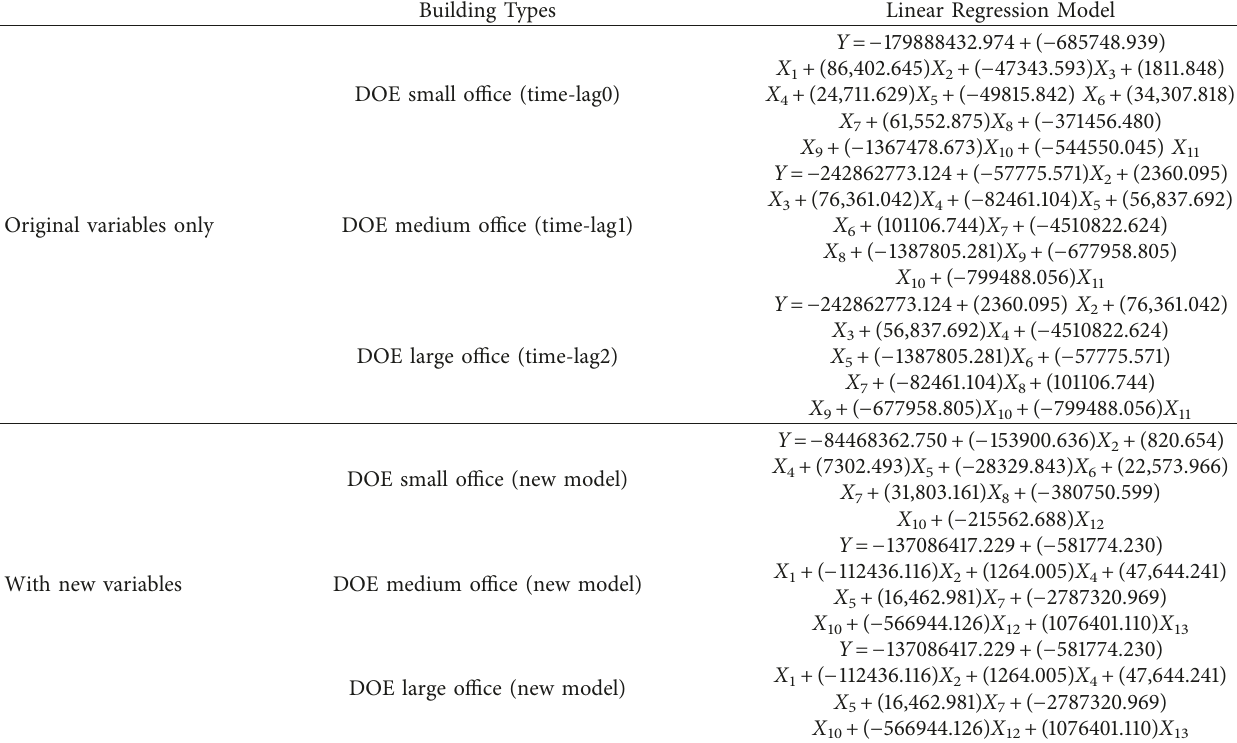
Table 26: Multiple regression equations using new variables based on building size. Building Types Linear Regression